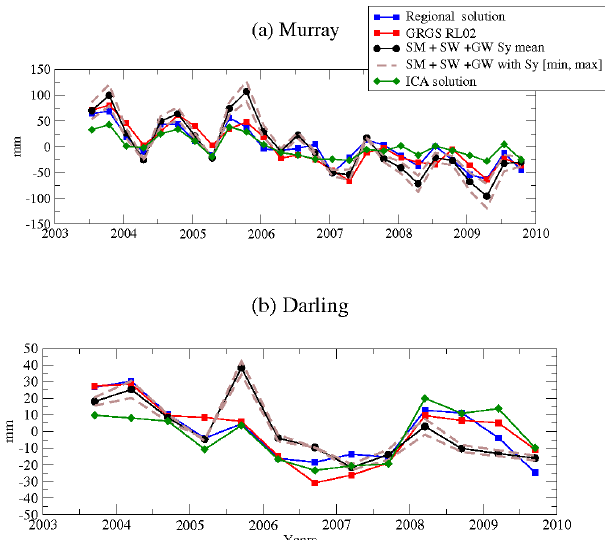
Fig. 15. (a) 3-month averaged time series of TWS over Murray Fig. 15. (a) 3 month averaged time series of TWS over Murray Basin and (b) 6 month averaged time series Basin and (b) 6-month averaged time series of TWS over Darling of TWS over Darling Basin for 2003–2010. Series are computed from GRACE-based regional solutions (blue Basin for 2003–2010. Series are computed from GRACE-based re- line), GRGS RL02 (red line), ICA 400km-filtered solutions (green line) and TWS estimated as groundwater gional solutions (blue line), GRGS RL02 (red line), ICA 400km- storage+surfacewaterobservations+modeledsoilmoisture(greylines). Discountionousgreyline: Maximum filtered solutions (green line) and TWS estimated as groundwa- and minimum values of the specific yield are used (values of 0.06 and 0.14); Continiuous grey line: mean value ter storage+surface water observations+modelled soil moisture of specific yield is used (0.01). (grey/black lines). Discontinuous grey line: maximum and min- imum values of the specific yield are used; continuous black line: mean value of specific yield is